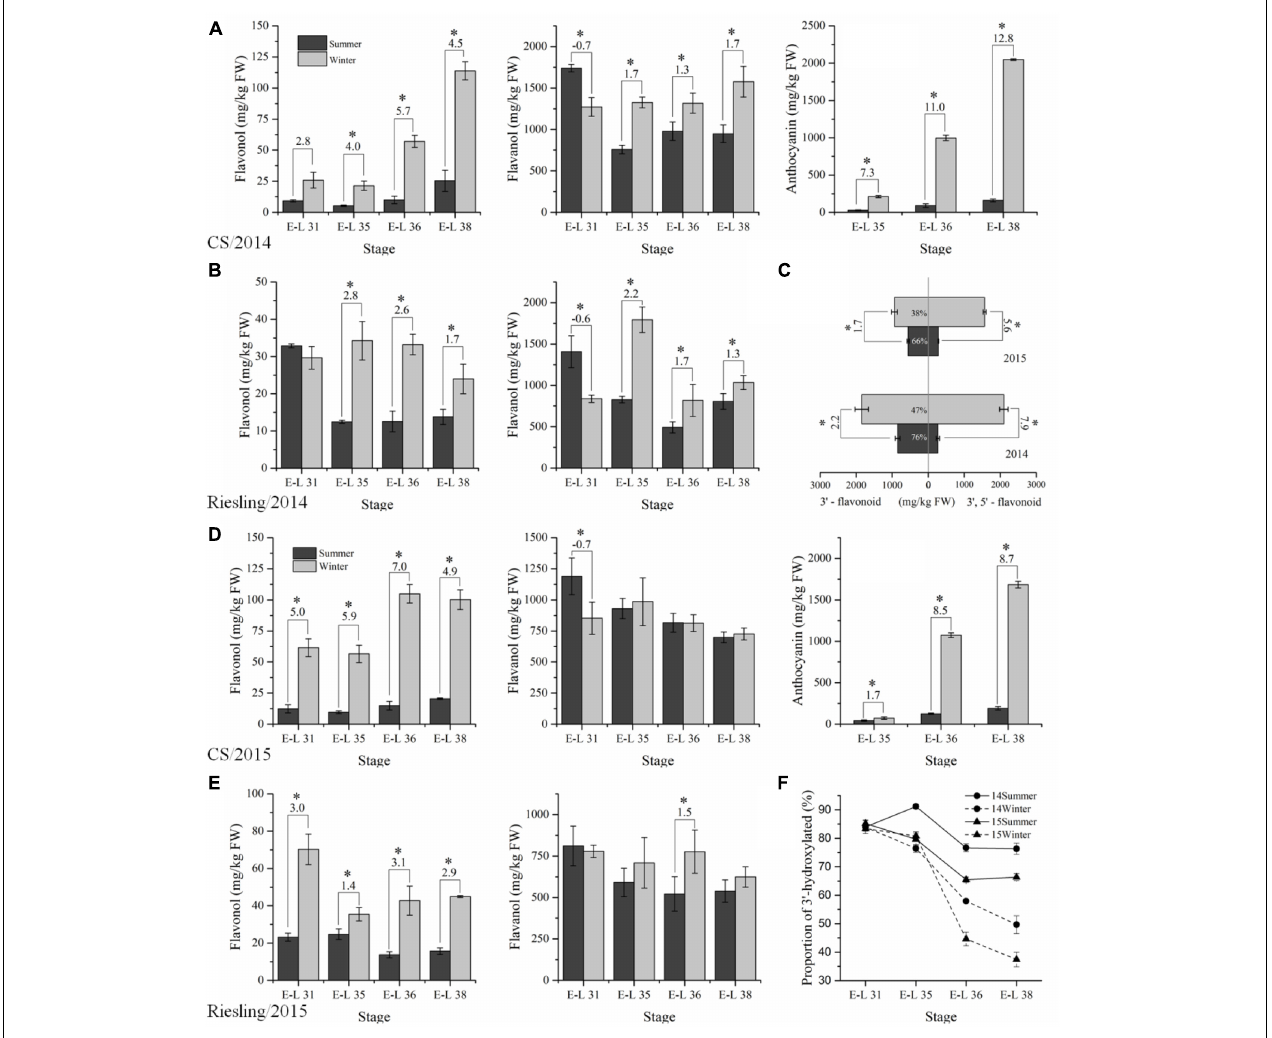
FIGURE 4 | The composition and content of flavonoid compounds extracted in “CS” (A,D) and “Riesling” (B,E) skins under double cropping viticulture system in 2014 (A,B) and 2015 (D,E) , the profiles of flavonoid at harvest stage in “CS” (C) and the proportion of 3 (cid:48) 4 (cid:48) -hydroxylated flavonoid in “CS” (F)